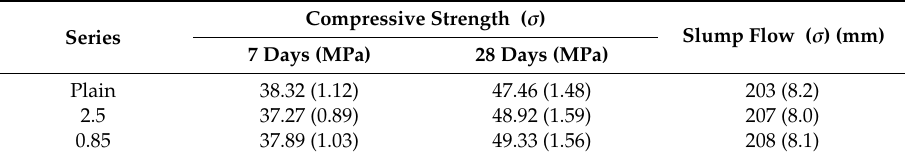
Table 5. Compressive strength and slump flow of considered mortars.